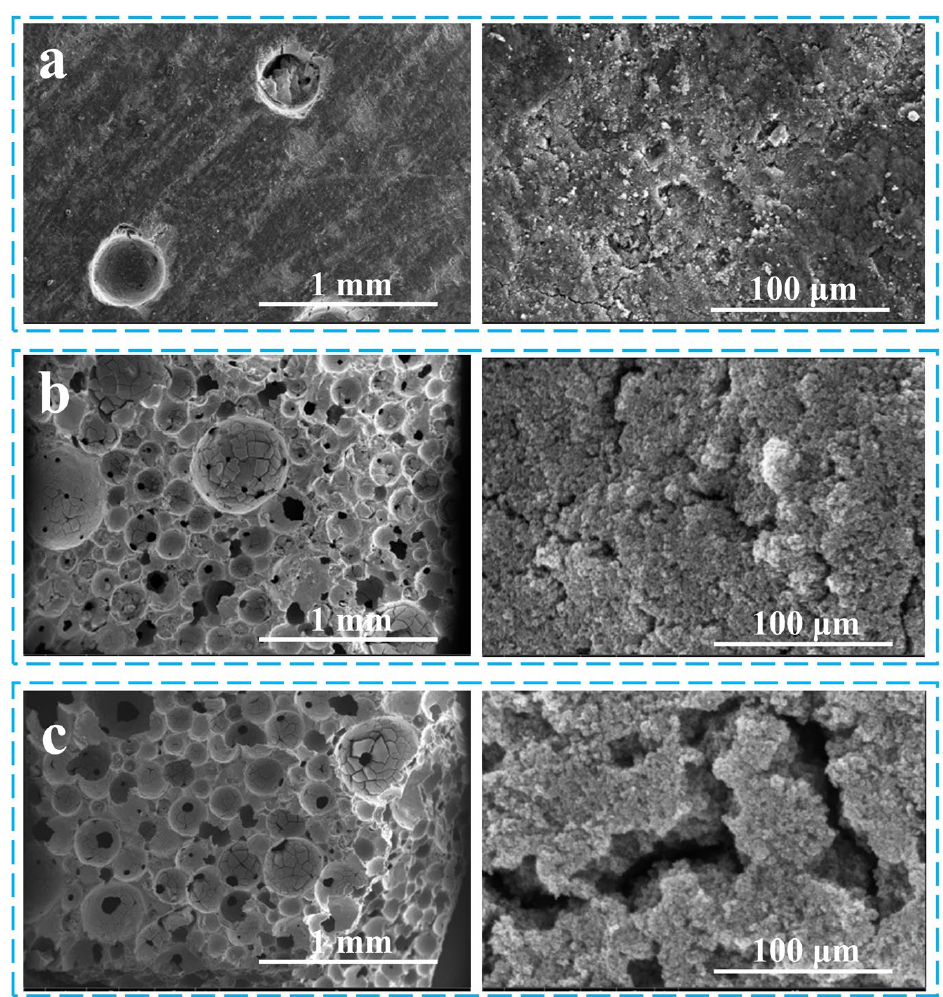
Figure 1. SEM images of PPMOC1 ( a ), PPMOC3 ( b ), and PPMOC5 ( c ). The PPMOC number means different porosity (shown in the experimental section).